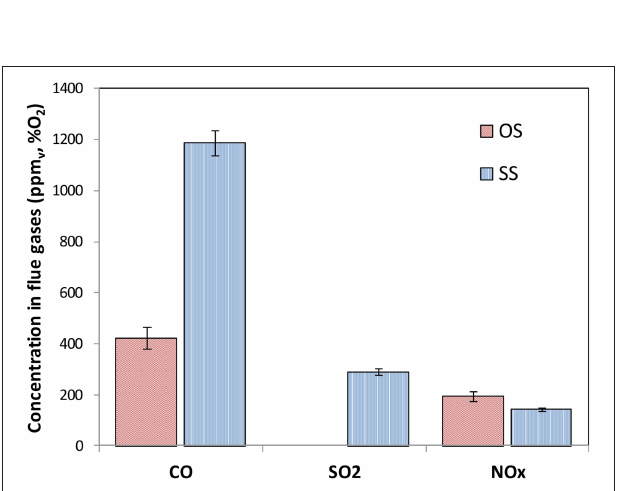
FIGURE 3 | Flue gas emissions, average ( ± standard error), of fuels, at F = 0.72 kg/h and λ =